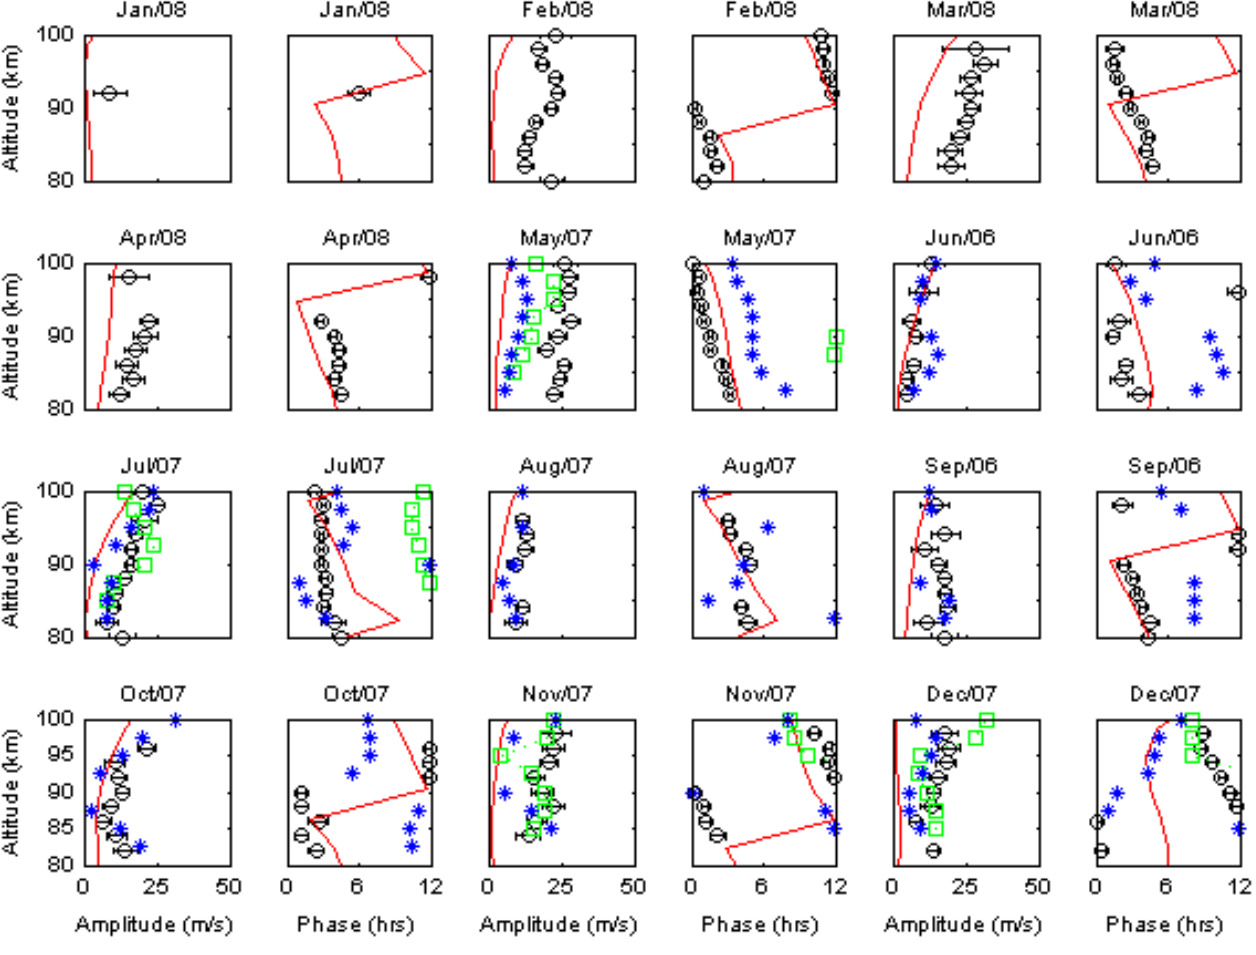
Fig. 5. Same as Fig. 2, but for meridional semidiurnal